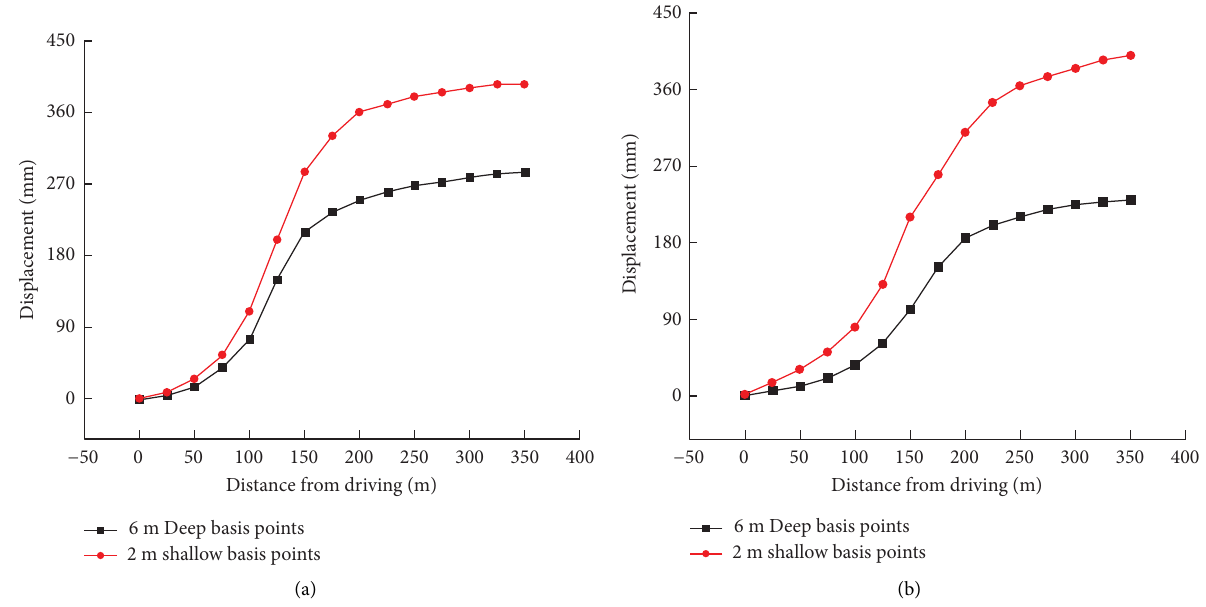
Figure 4: Roof deformation monitoring data from the repaired roadway. (a) Roof monitoring data at 540m. (b) Roof monitoring data at 640m.